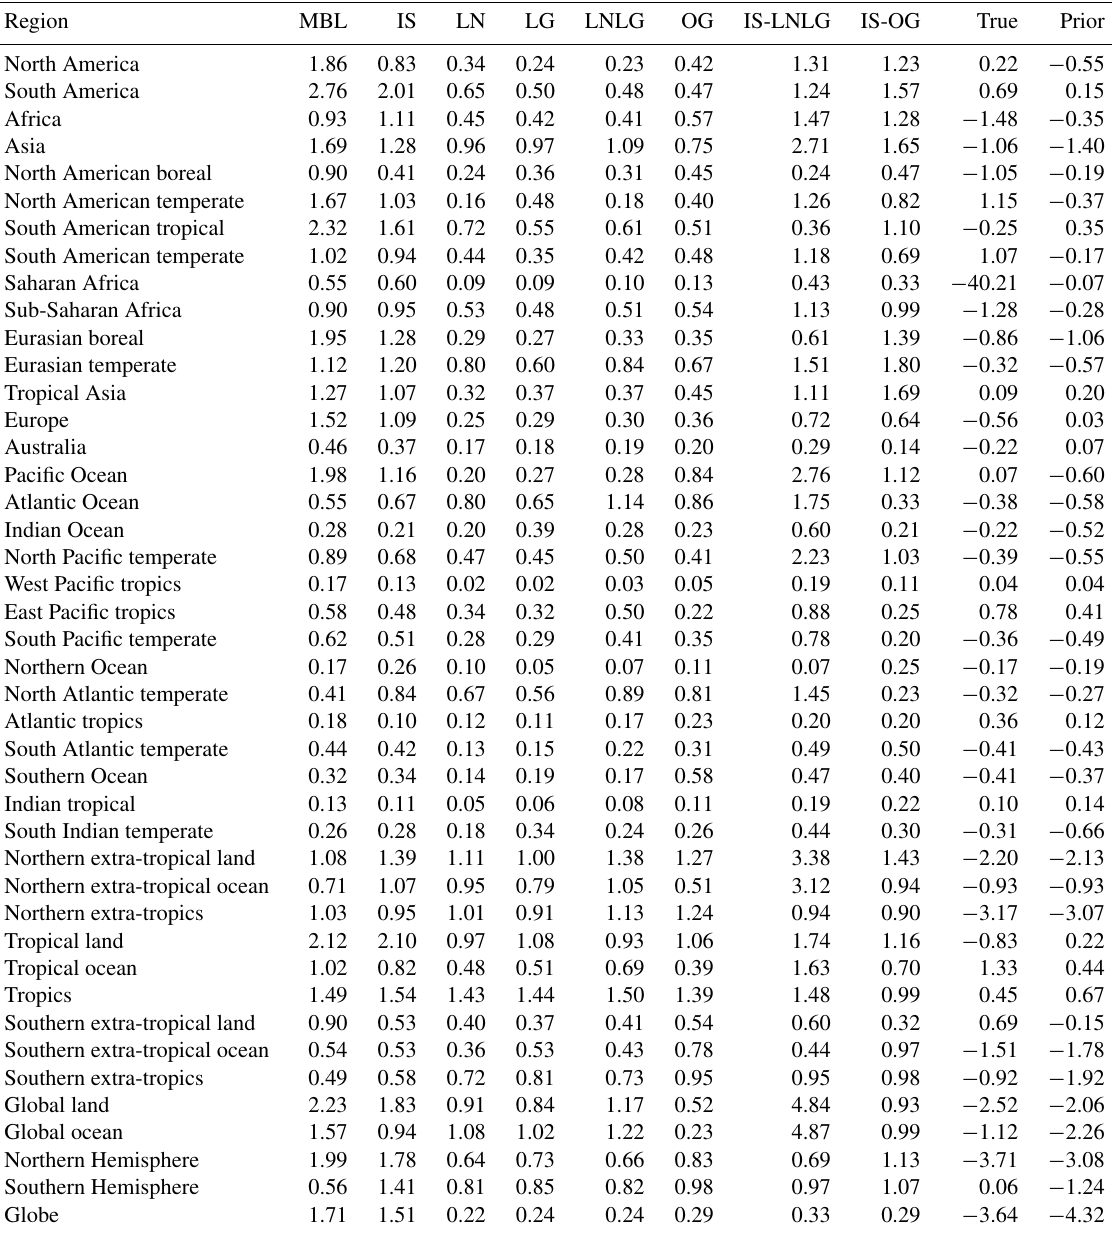
Table C1. The spread in annual flux estimates for 2015 across the five forward models. These are the vertical extents of the color bars in Fig. 4. The true and prior fluxes (white circle and gray diamond in Fig. 4) are also included as the last two columns of the table. All numbers are in PgCyr − 1